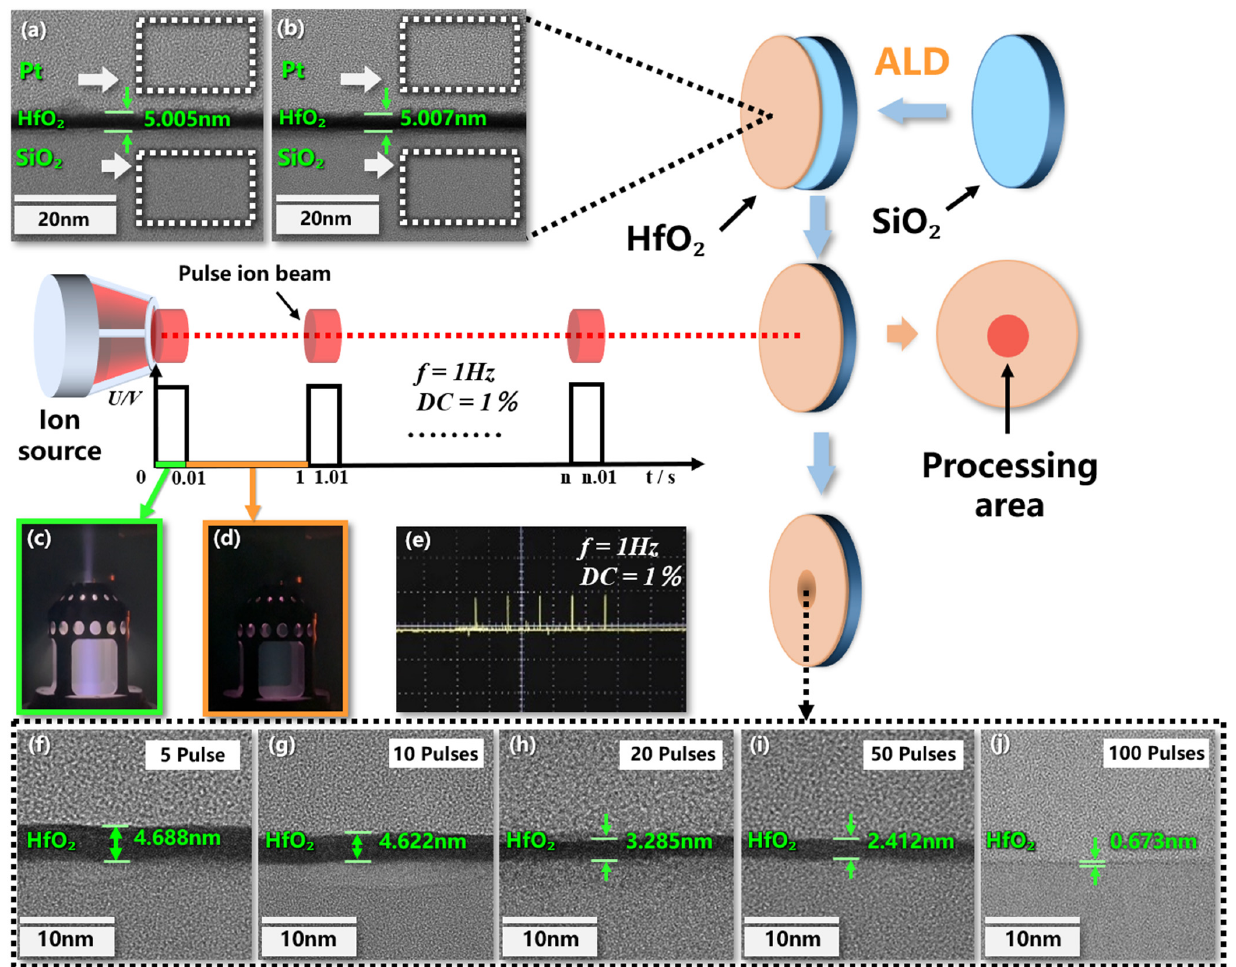
Figure 1. Changes of coating layers during pulsed ion beam processing: ( a , b ) Initial coating information of random two samples; ( c ) beam on; ( d ) beam off; ( e )pulse waveform; ( f ) after 5 pulses; ( g ) after 10 pulses; ( h ) after 20 pulses; ( i ) after 50 pulses; ( j ) after 100 pulses.